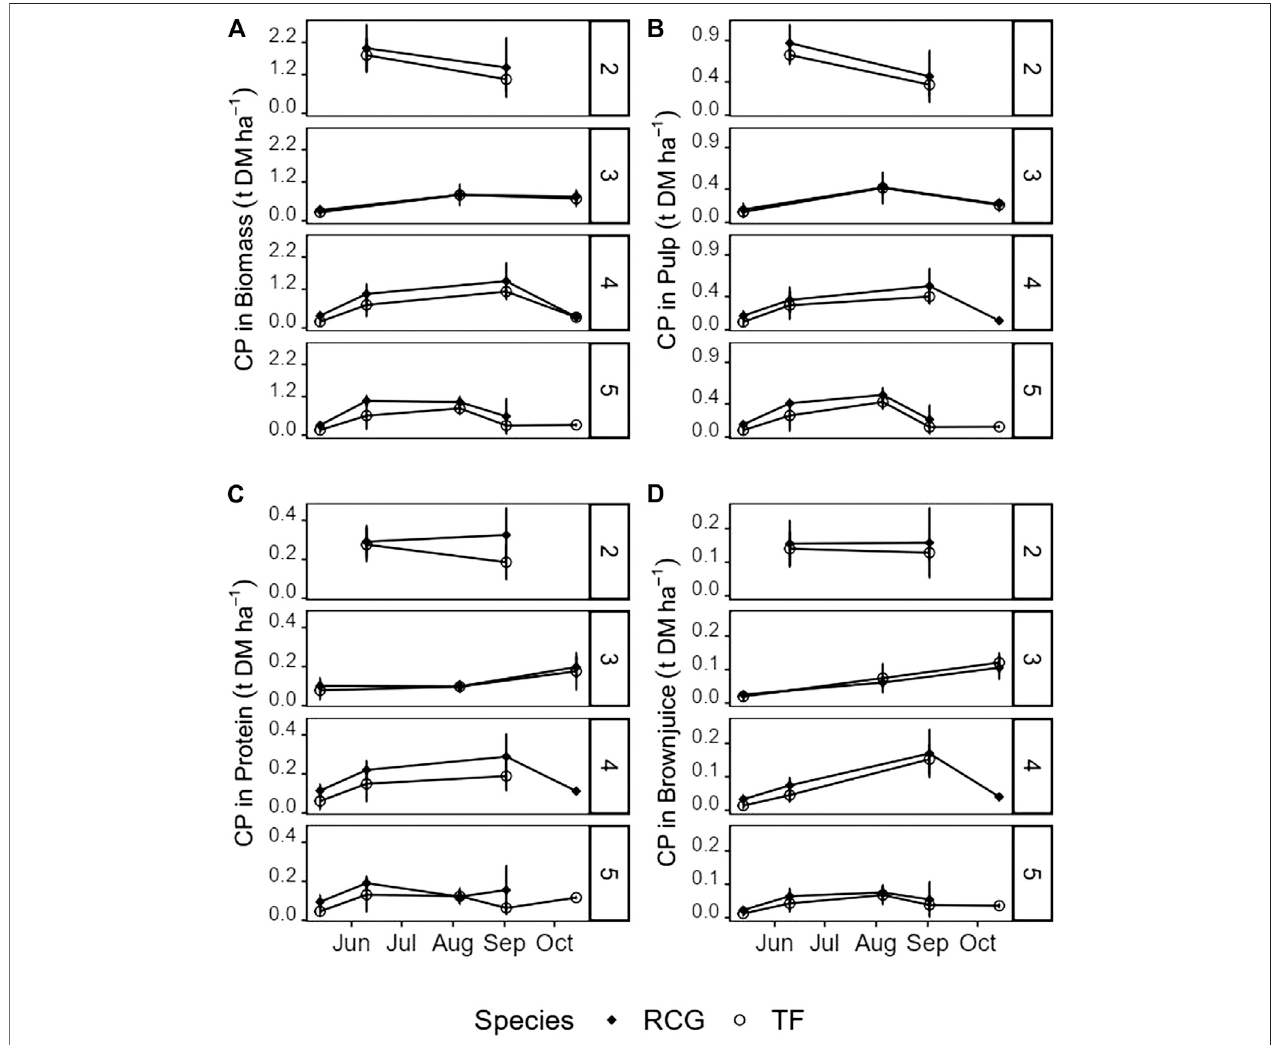
FIGURE6| Yieldsofcrudeprotein(tha − 1 )in (A) unseparatedbiomass,andthescrew-pressedfractions (B) pulp, (C) proteinprecipitate,and (D) brownjuiceforthe various treatments and species on the different harvest dates. Attention should be paid to the different magnitudes of the y-axes. Missing values for late cuts of the four, and fi ve cut treatments due to insuf fi cient biomass for juicing in the screw-press. Error-bars show standard deviations.